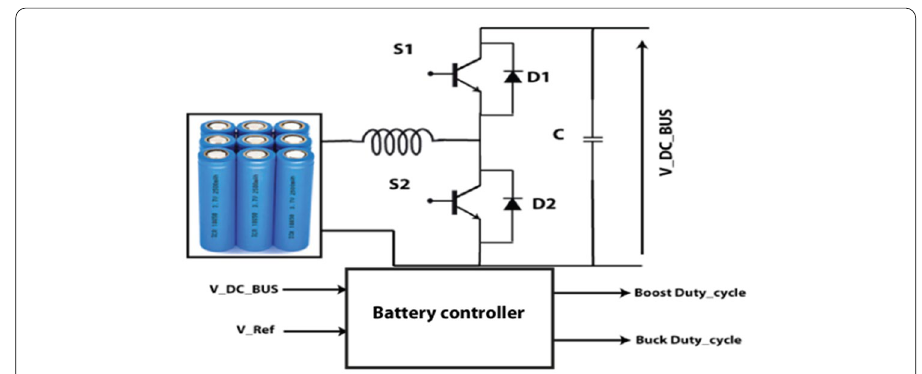
Fig. 7 Battery storage system with controller